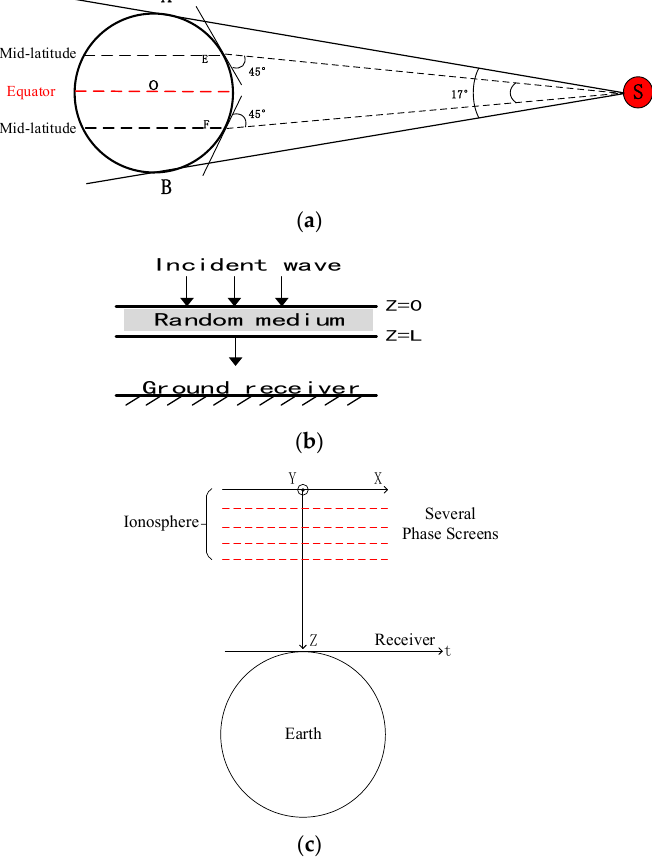
Figure 2. ( a ) Schematic figure of Medium Earth Orbit (GEO); ( b ) Propagation of incident wave; ( c ) Coordinate system. ( c ) Coordinate